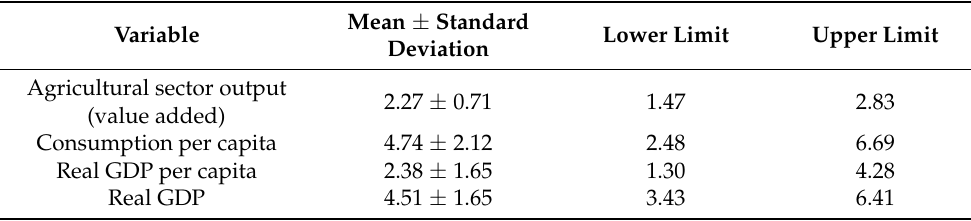
Table 2. Projected average annual growth (%) in selected variables in a baseline (no GERD) scenario over the next 3